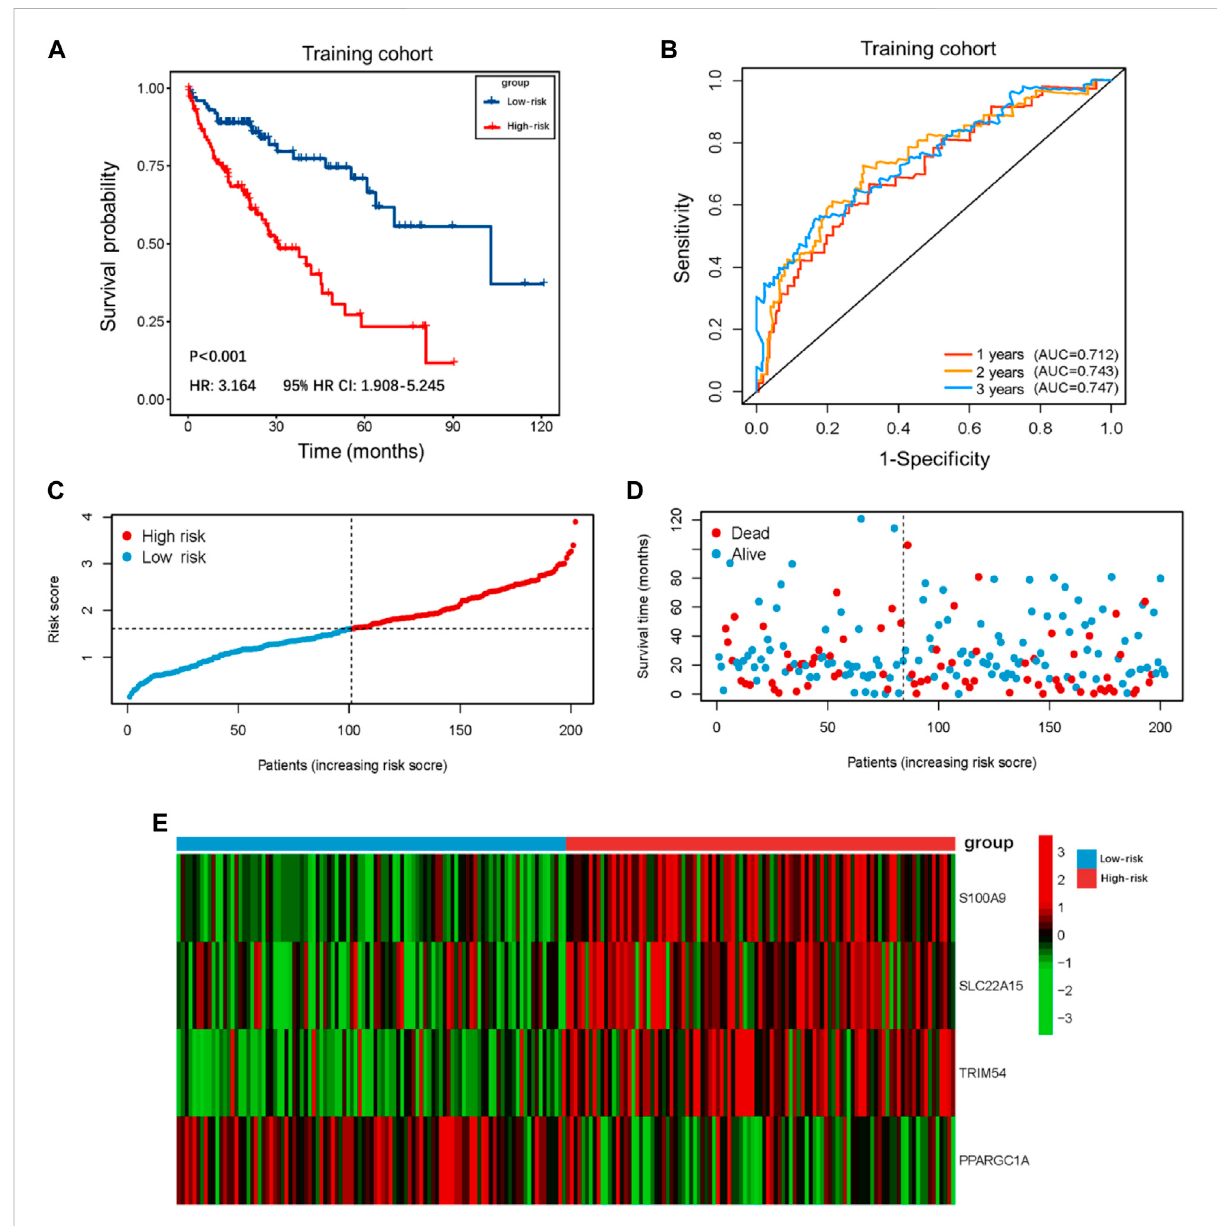
FIGURE 3 Survivalanalysis ofthetraining cohort. (A) K – Mcurveforthetraining cohort.Patients inthelow-risk grouprepresentedabetterOS. (B) The1,2, and 3 years ROC curves of the risk score in the training cohort. (C) Distribution of risk score of liver cancer patients in the training cohort. (D) Distribution of survival status of liver cancer patients in the training cohort. (E) Heatmap of the TIMGs in the training